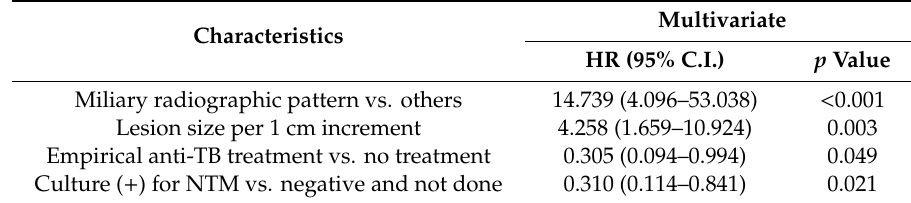
Table 3. Multi-variable analysis for early obtained pathology.